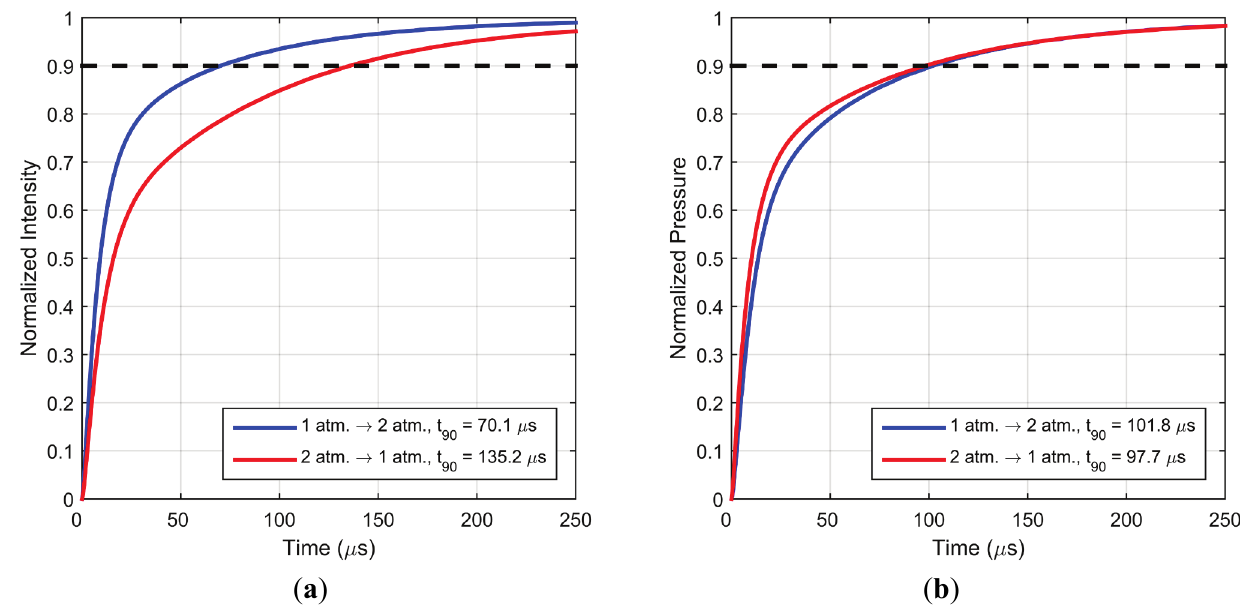
Figure 11. ( a ) Simulated intensity response; ( b ) Simulated pressure response for a typical sample for a step change in pressure between 1 atm. and 2